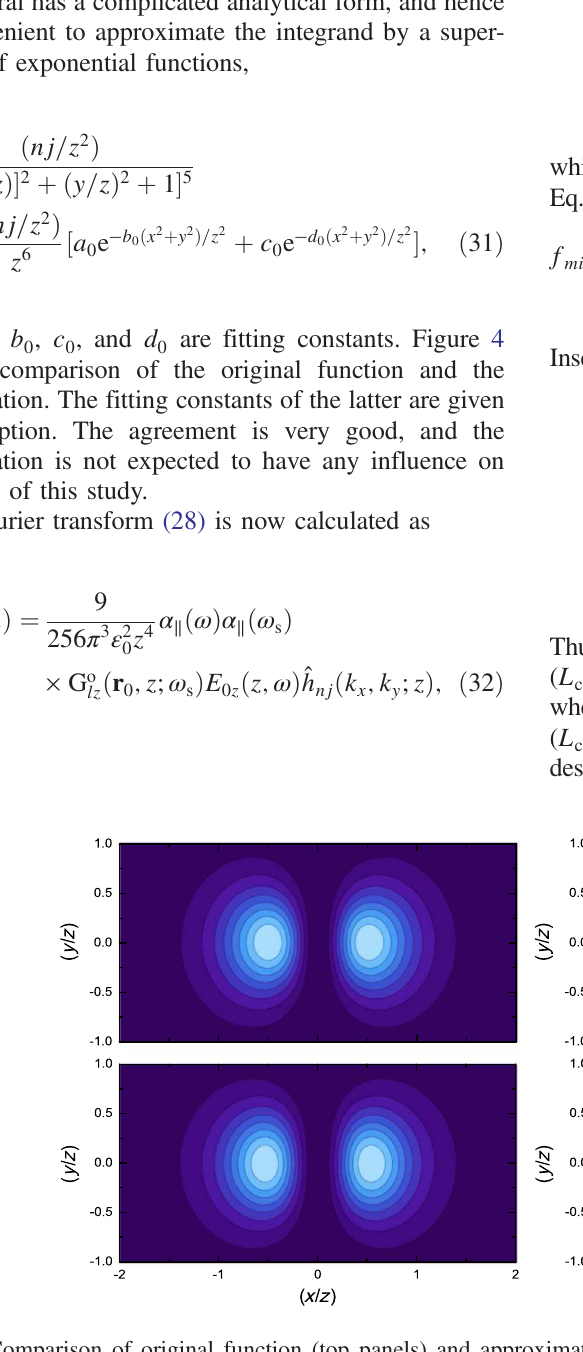
FIG. 4. Comparison of original function (top panels) and approximation (bottom panels) according to Eq. (31). The left panels correspond to n ¼ j ( ¼ x in this case), while the right panels correspond to n ≠ j . In both cases, the following fitting constants were used: a 0 ¼ 0 . 74 , b 0 ¼ 4 . 0 , c 0 ¼ 0 . 08 , and d 0 ¼ 1 . 5